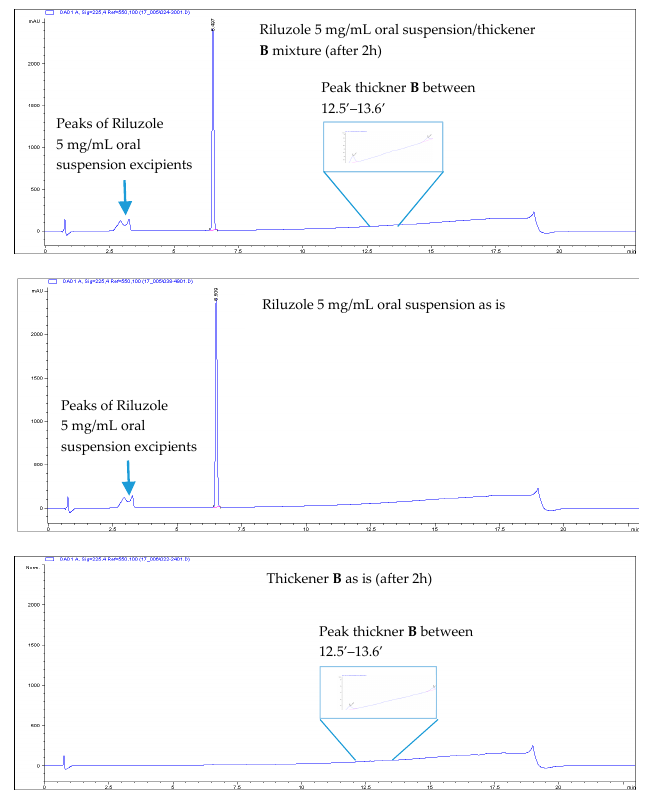
Figure 2 Figure 2. Comparison of chromatograms: Riluzole 5 mg / mL oral suspension / thickener B mixture (after 2 h); Riluzole 5 mg / mL oral suspension as is and Thickener B as is (after 2 h).